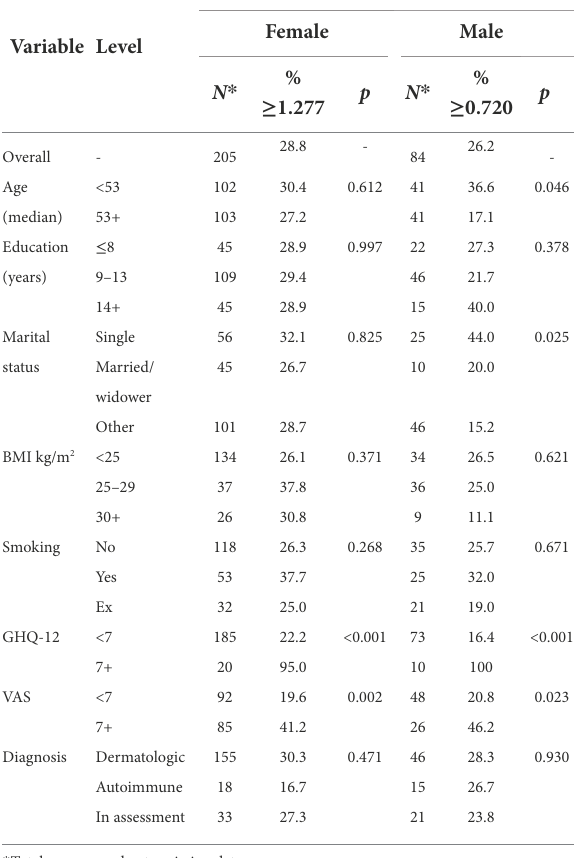
TABLE 2 Proportion of participants, separately for women and men, who reach the SCL-K-9 proposed cut-offs. SCL-K-9 tot. ≥ cut-off Female Male Variable Level